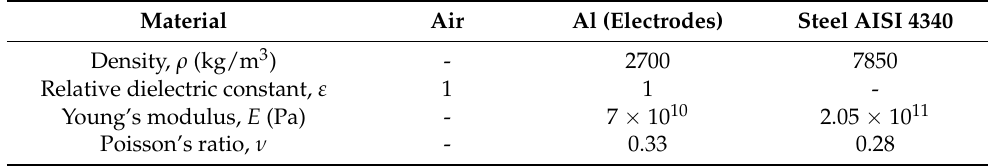
Table 1. Non-piezoelectric material parameters used in the simulation.